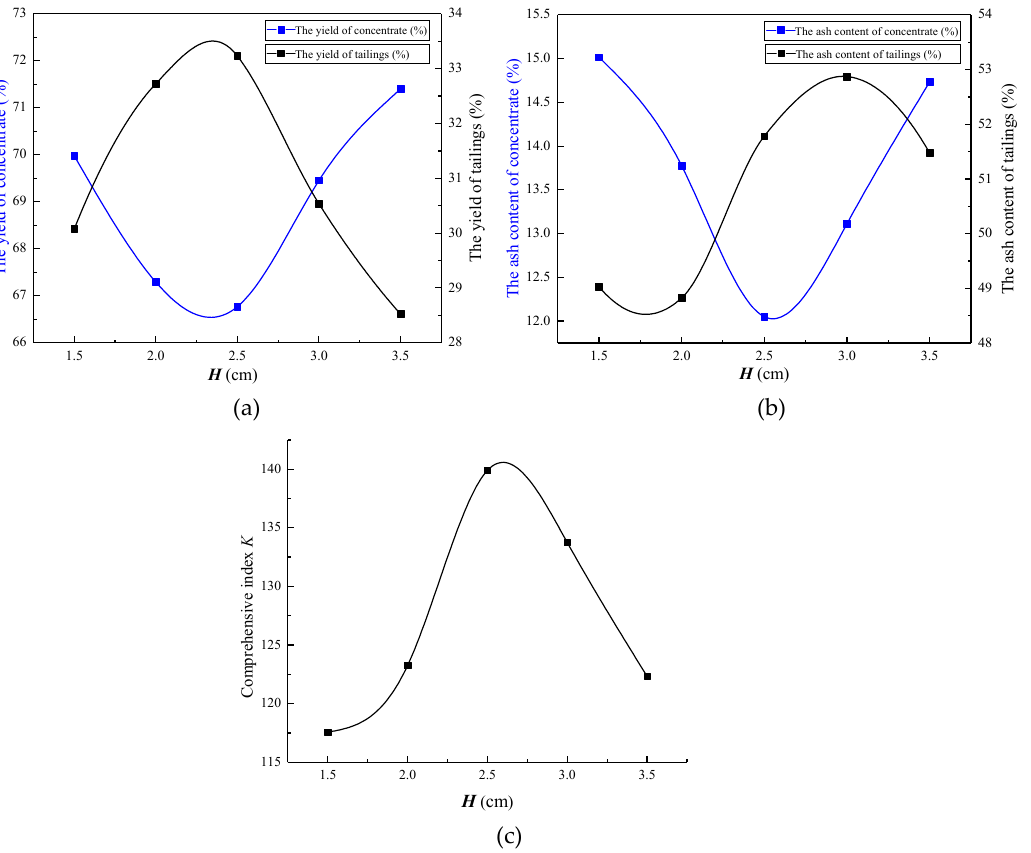
Figure 6. Effect of H on the separation effect. ( a ) Effect of the H on yield; ( b ) effect of the H on ash Figure 6. E ff ect of H on the separation e ff ect. ( a ) E ff ect of the H on yield; ( b ) e ff ect of the H on ash content; ( c ) effect of the H on K . content; ( c ) e ff ect of the H on K